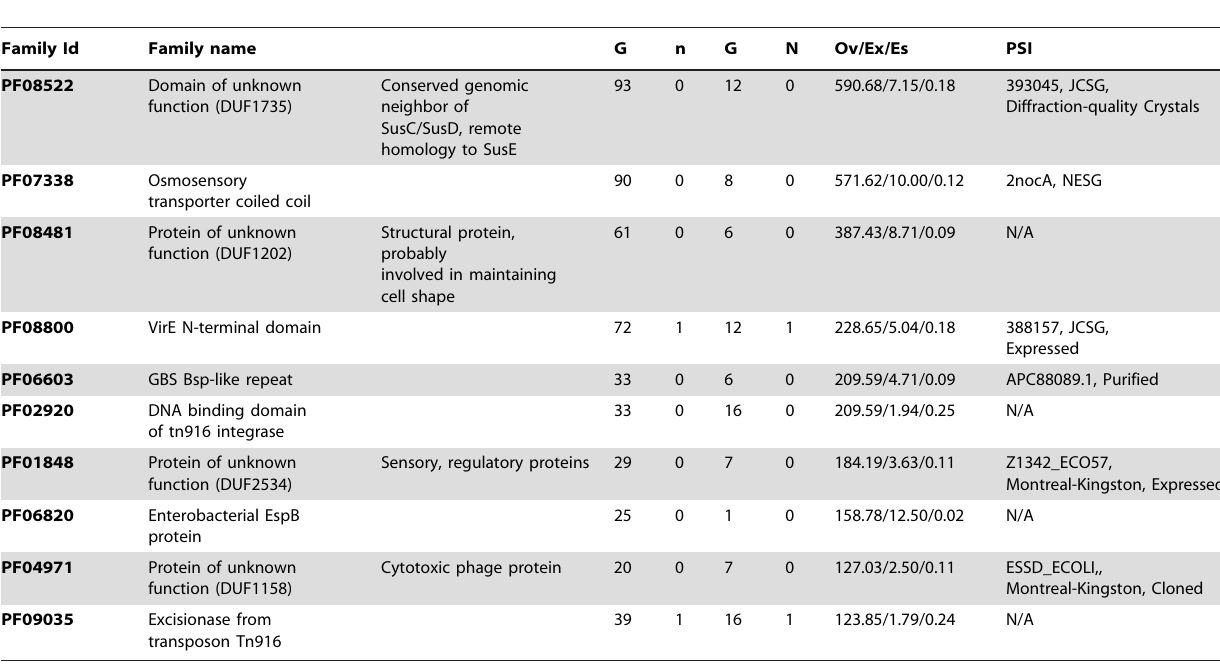
Table 1. The 10 most overrepresented (Ov) PfamA families in human gut microbiome.